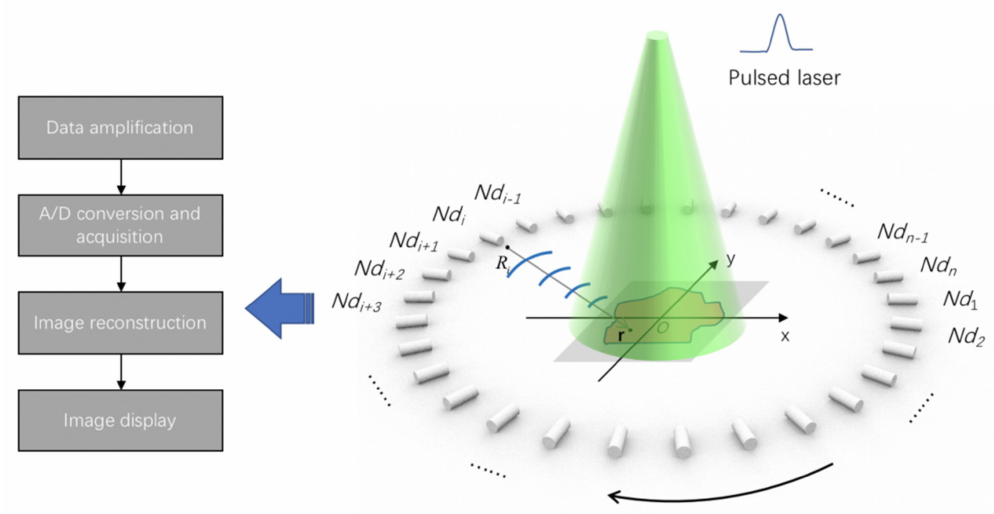
Figure 1. 2D circular-scanning-based PAT